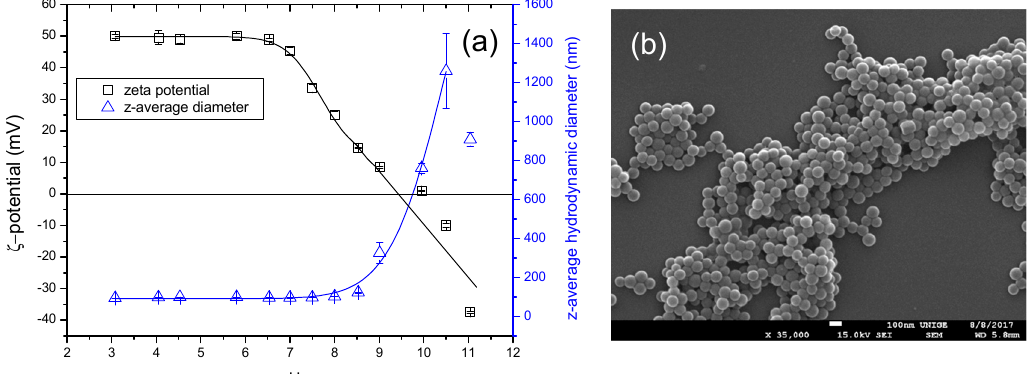
Figure 3. ( a ) ζ potential and z-average hydrodynamic diameter variation of amidine PS nanoplastic particles (10 mg / L) as a function of pH in ultrapure water. The point of zero charge (PZC) is found at pH = 9.9 ± 0.1. Aggregation is observed around the PZC region (gray domain), and ( b ) SEM image of PS nanoplastic aggregates in ultrapure water at pH > pH pzc . SEM analysis indicates spherical and monodispersed nanoplastics.